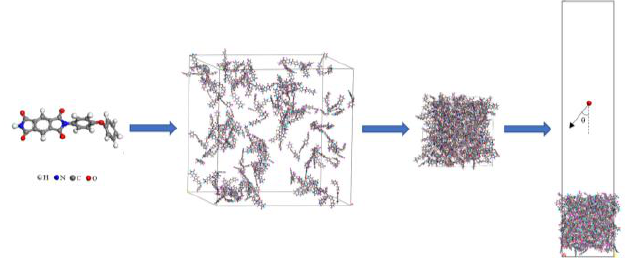
Figure 2. Modeling steps of Kapton structure.